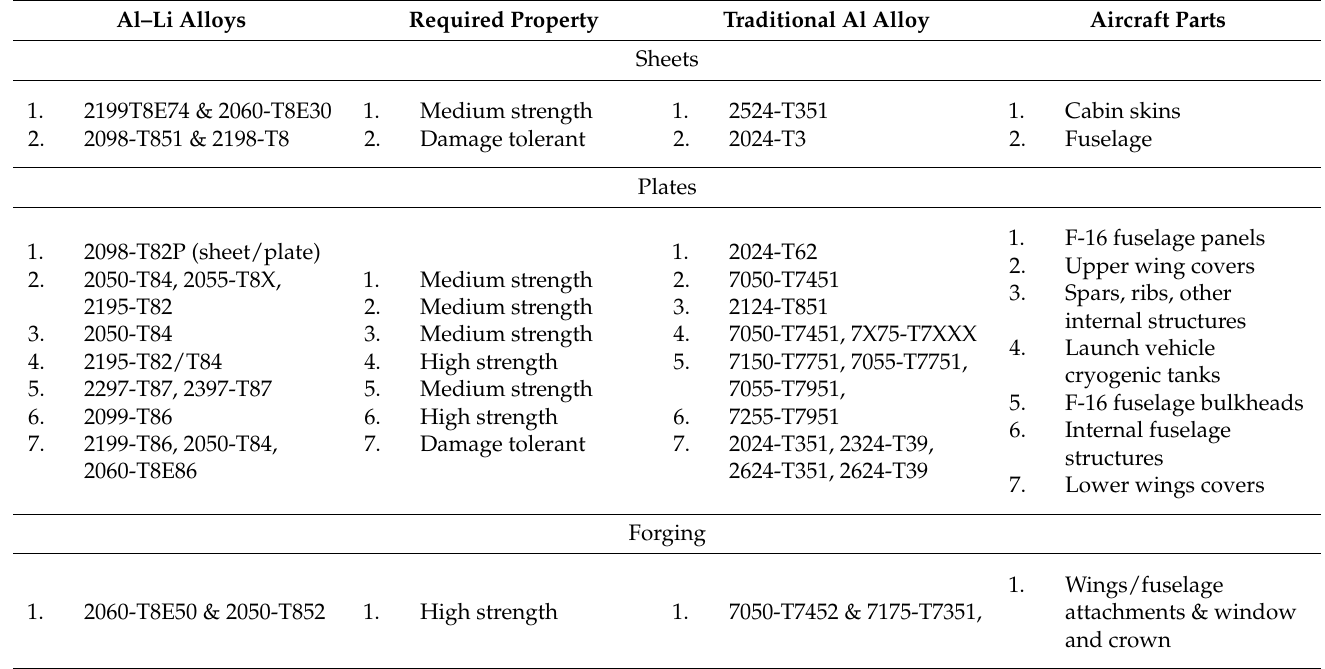
Table 2. The proposed Al–Li alloys replace the traditional Al alloys in the aircraft industry [143] (has permission from